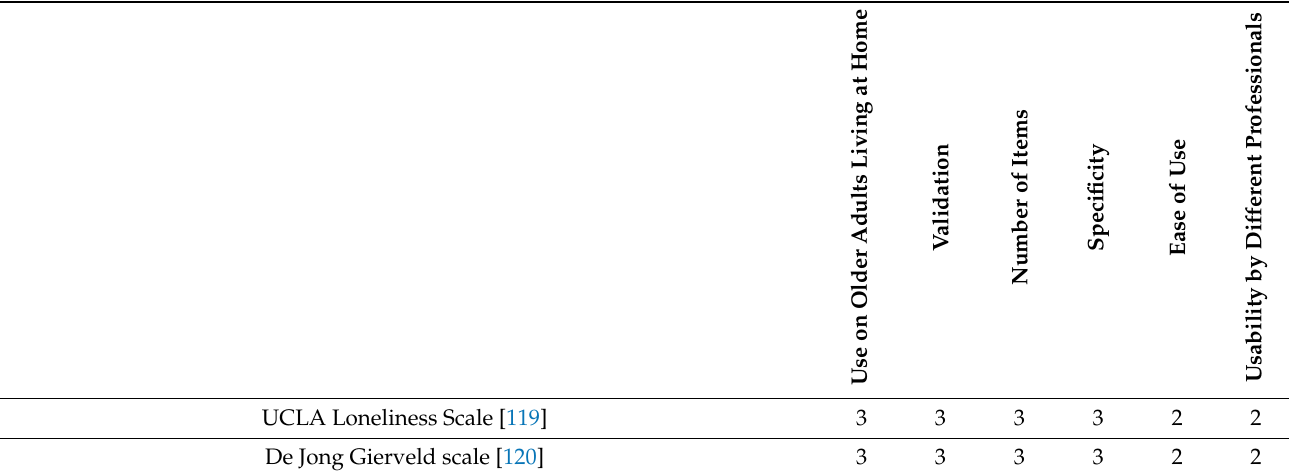
Table 8. Support network assessment tools